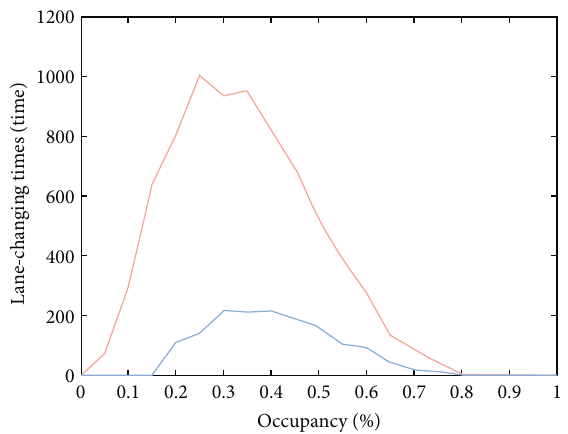
Figure 2: Lane-changing times-space occupancy fi gure.